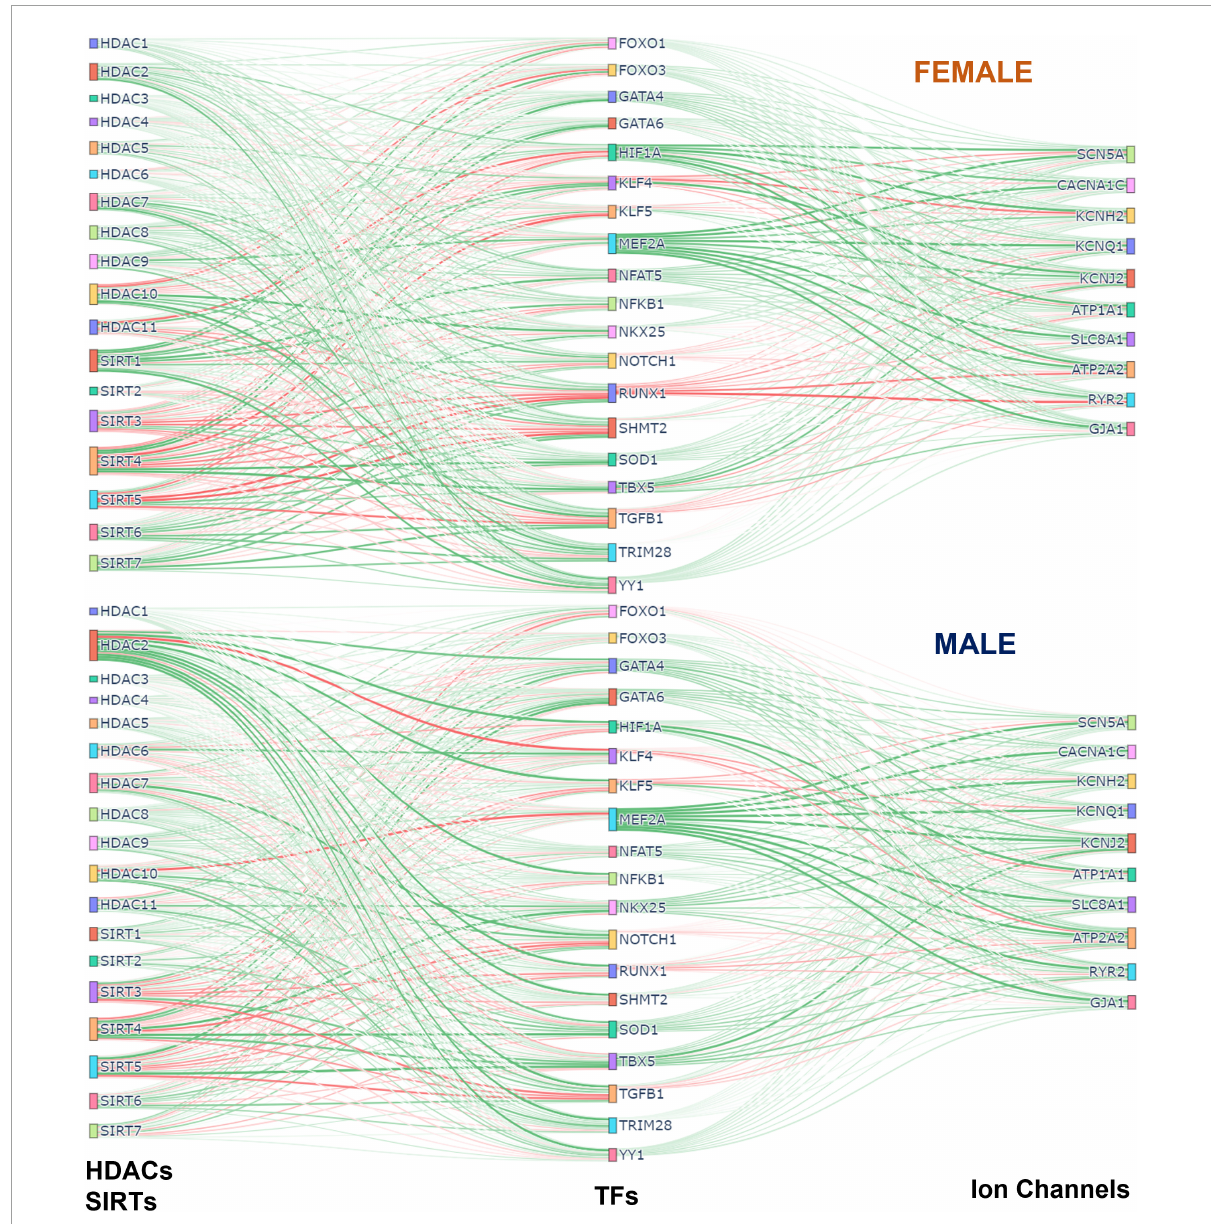
FIGURE7 Integrated (Sankey) flow diagrams of how HDACs and SIRTs influence ion channels via cardiac TFs. PLS regression models (for female samples on top and male samples on bottom) were trained using HDACs and SIRTs to predict TFs and then using TFs to predict cardiac ion channels. The resulting B-matrix coefficients were utilized to create the plots. The width and color intensity of the lines correspond to the strength of the B-matrix coefficients, and the color distinguishes between positive (green) and negative (red) coefficients. Note that in some cases, double negative regulation (e.g., SIRT3 - > RUNX1 - > RYR2) results in positive input-output